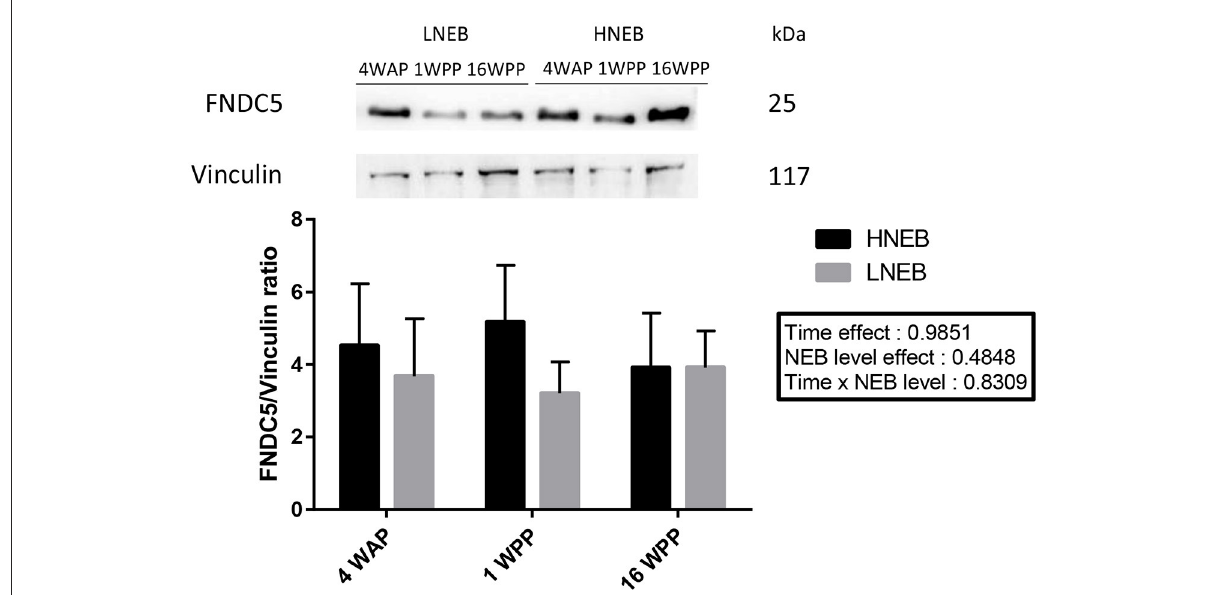
FIGURE6 Protein expression of FNDC5 in bovine subcutaneous adipose tissue during peripartum period. Protein expression of FNDC5 was determined by western blot in tissues obtained 4 weeks before parturition (4WAP) and 1 (1WPP) and 16 weeks post-partum (16 WPP). A representative blot is shown above the means. Data are expressed as mean ± SEM for each group ( n = 8 in LNEB group and n = 13 in HNEB group) and analyzed by a nonparametric analysis of variance with repeated measures (Friedman test).